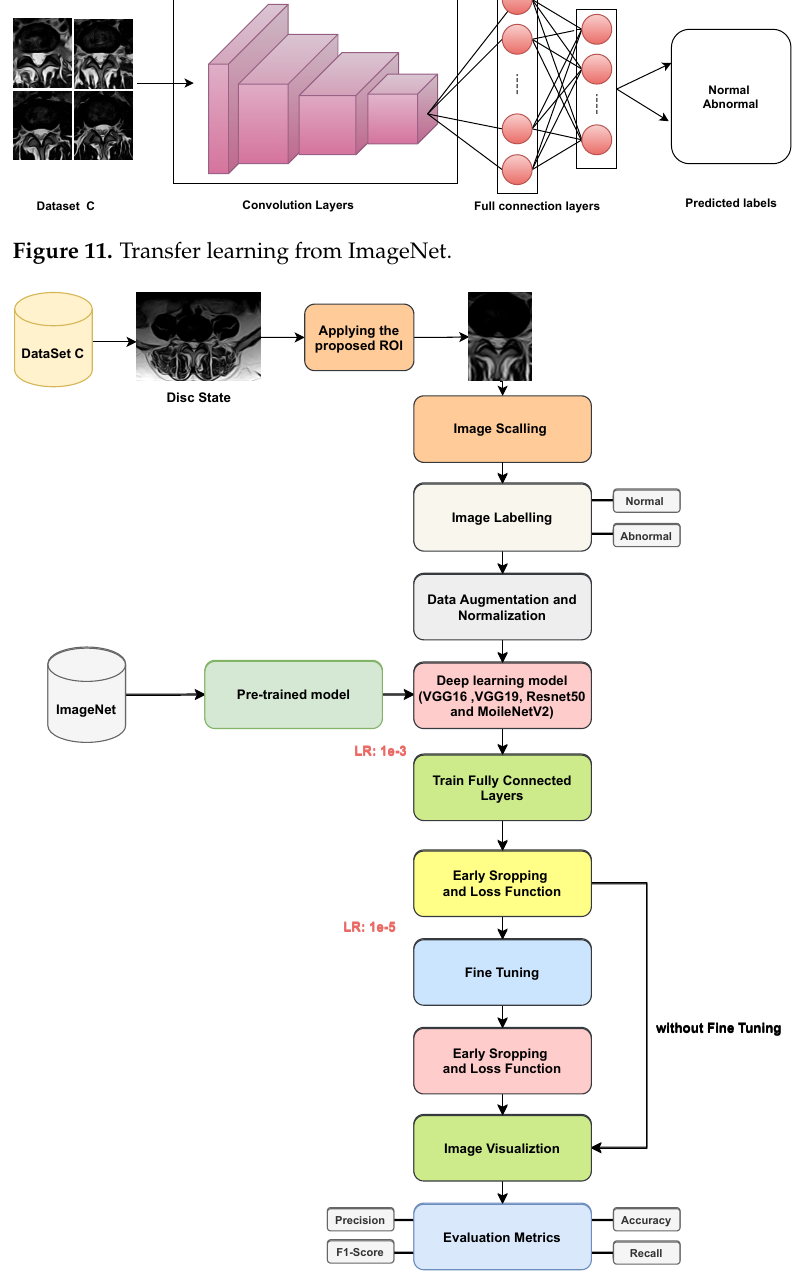
Figure 12. Transfer learning disc state classification with proposed